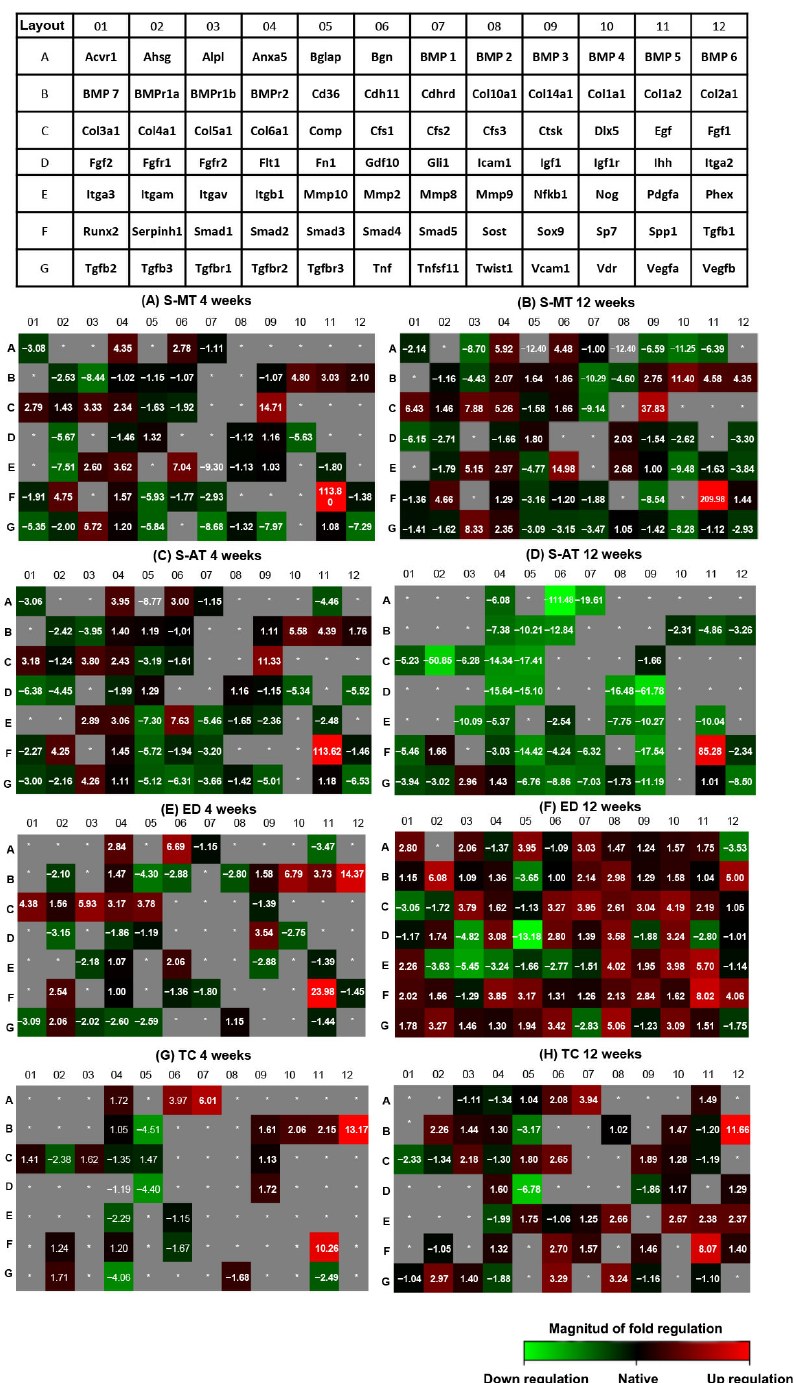
Figure 8. Gene expression in explanted samples at 4 weeks (left column) and 12 weeks (right column) after implantation (n = 8). (Top table) Plate layout with 84 genes investigated. Heat maps represent fold regulation of the gene expression compared to native tissue. Green indicates downregulation, red indicates upregulation, grey* indicates undetected expression and black indicates native levels of expression (= no regulation compared to native tissue). ( A , B ) S-MT, silk scaffold with mixed transition; ( C , D ) S-AT, silk scaffold with abrupt transition; ( E , F ) ED, empty defect; ( G , H ) TC, transversal cut.